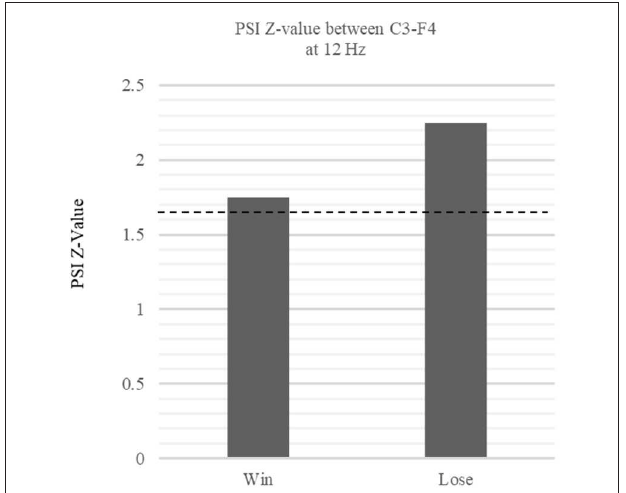
FIGURE 7 | Comparison of PSI Z-values in win vs. lose trials between C3 and F4 phase relationship. The figure shows the z -values of the within-frequency phase synchronization index (PSI) between the win and lose trials at 12Hz. The dotted lines denote the threshold value ( p < 0.05, one-tail). The phase relationship between C3-F4 at 12Hz exceeded the threshold during the win trials, indicating significant functional connectivity between C3 and F4 (Win: Z = 1.75 p < 0.05, Lose: Z = 2.25 p < 0.05).